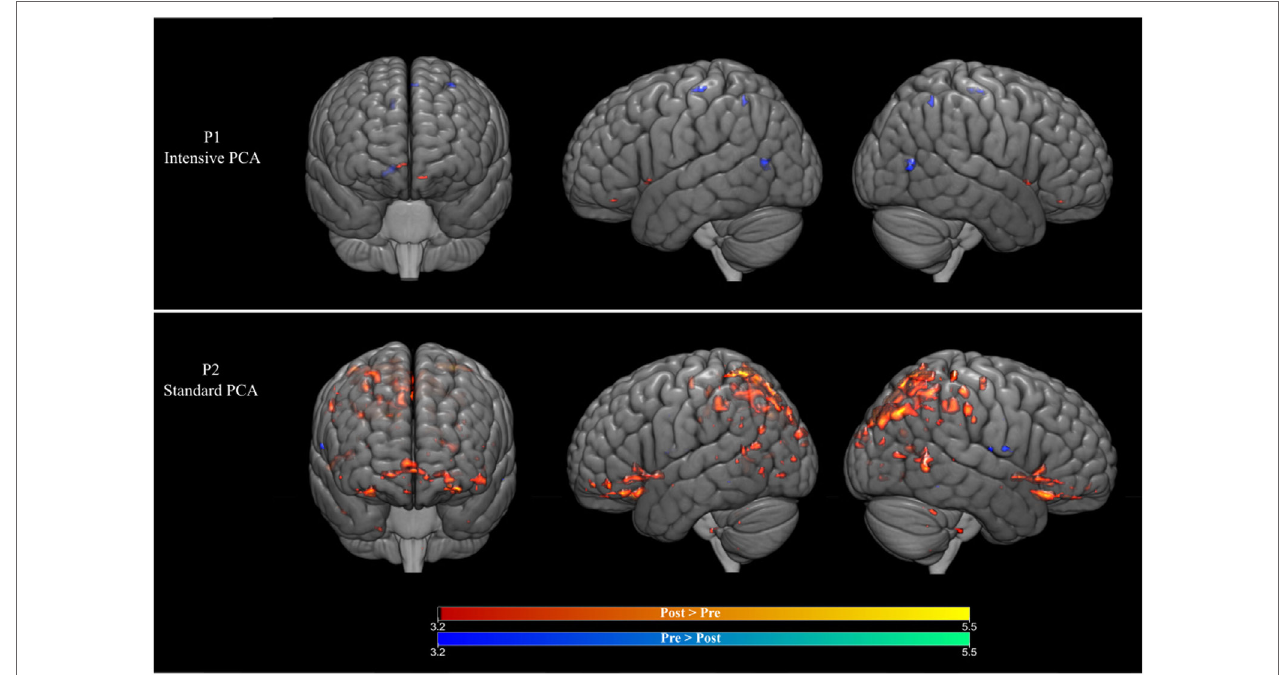
FIGURe 2 | (Top row) Brain activation changes for participant P1 who received the intensive phonological components analysis (PCA). (Bottom row) Brain activation changes for participant P2 who received the intensive PCA. Decreases in activation during treatment are shown in blue, whereas increases in activation are shown in red ( p < 0.001, > 5 contiguous